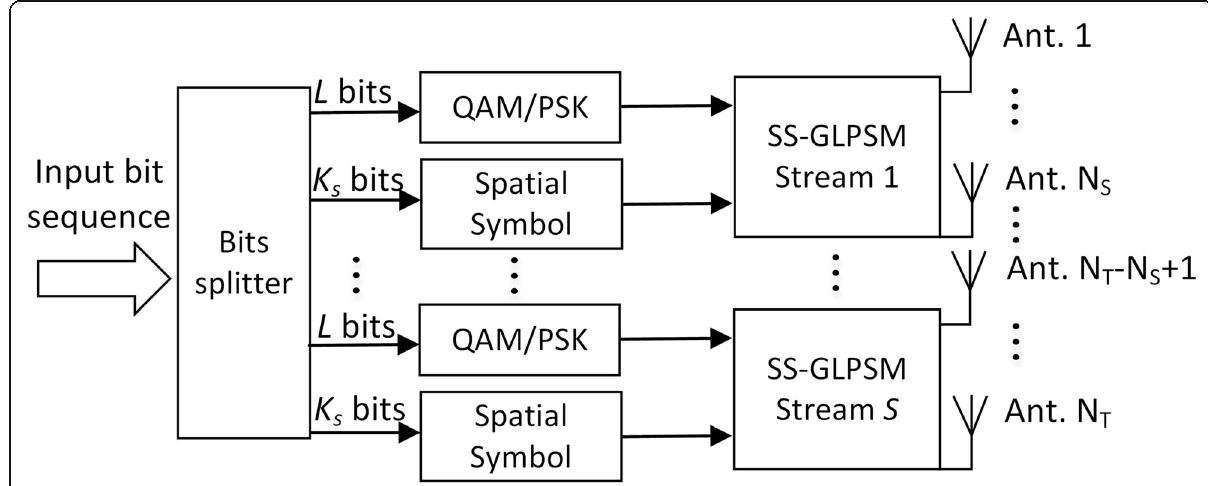
Fig. 2 The block scheme of SC-FDMA MS-GLPSM transmitter with N T antennas. In this case, the input bit sequence is divided into 2 S subsequences, where S is the number of streams. Two subsequences, as it is the case for SS-GLPSM, are used for each stream for SS-GLPSM coding. MS-GLPSM transmitter can be observed as S SS-GLPSM transmitters, each occupying its subset of